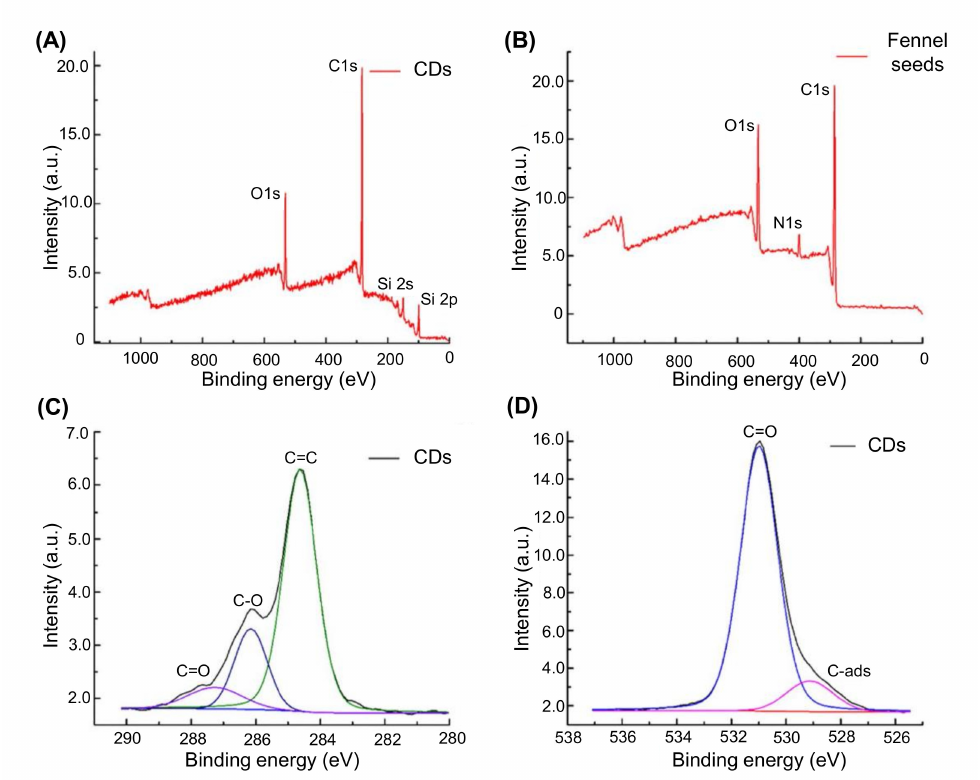
Figure 11. XPS spectra of: ( A ) CDs revealing O1s and C1s peaks. ( B ) Fennel seeds with C, N, and O composition. ( C ) C1s. ( D ) O1s